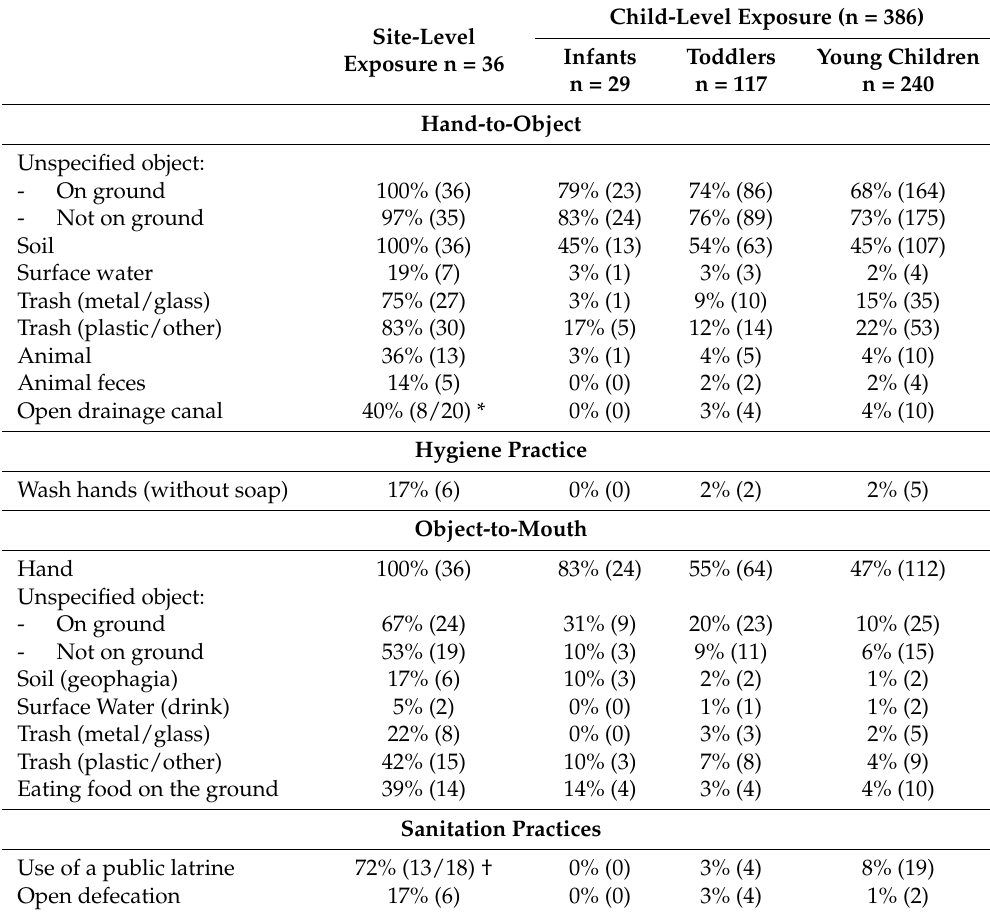
Table 3. Number of observation sites (site-level exposure) and children (child-level exposure) observed to practice a behavior.